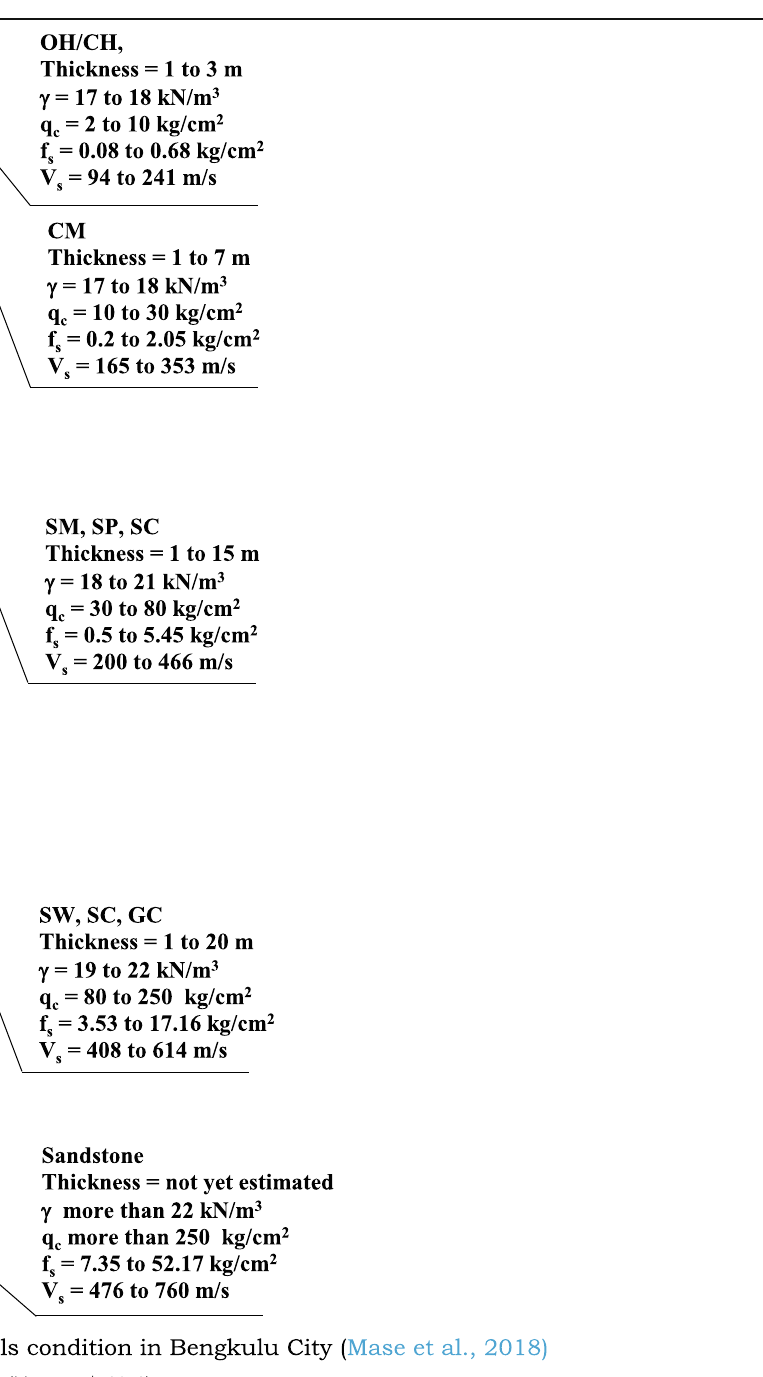
Fig. 3 Typical subsoils condition in Bengkulu City (Mase et al.,